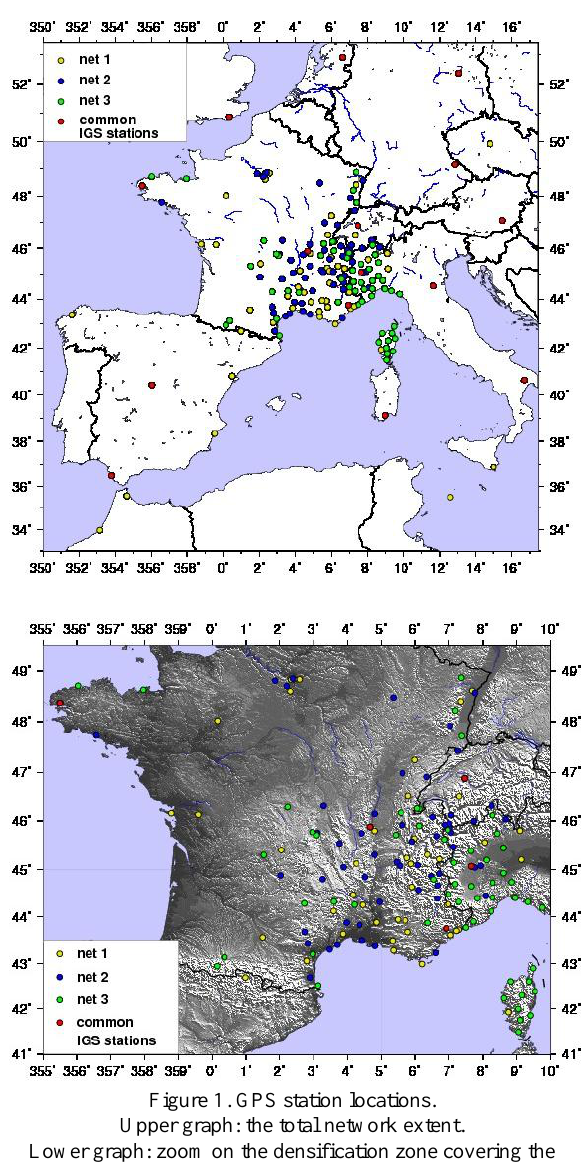
Figure 1. GPS station locations. Upper graph: the total network extent. Lower graph: zoom on the densification zone covering the French-Italian Mediterranean coast and the western Alps. Red circles highlight the 15 common IGS and EUREF stations included in each of the three sub-networks net1 (yellow circles), net2 (blue circles) and net3 (green circles) composed according to decreasing station